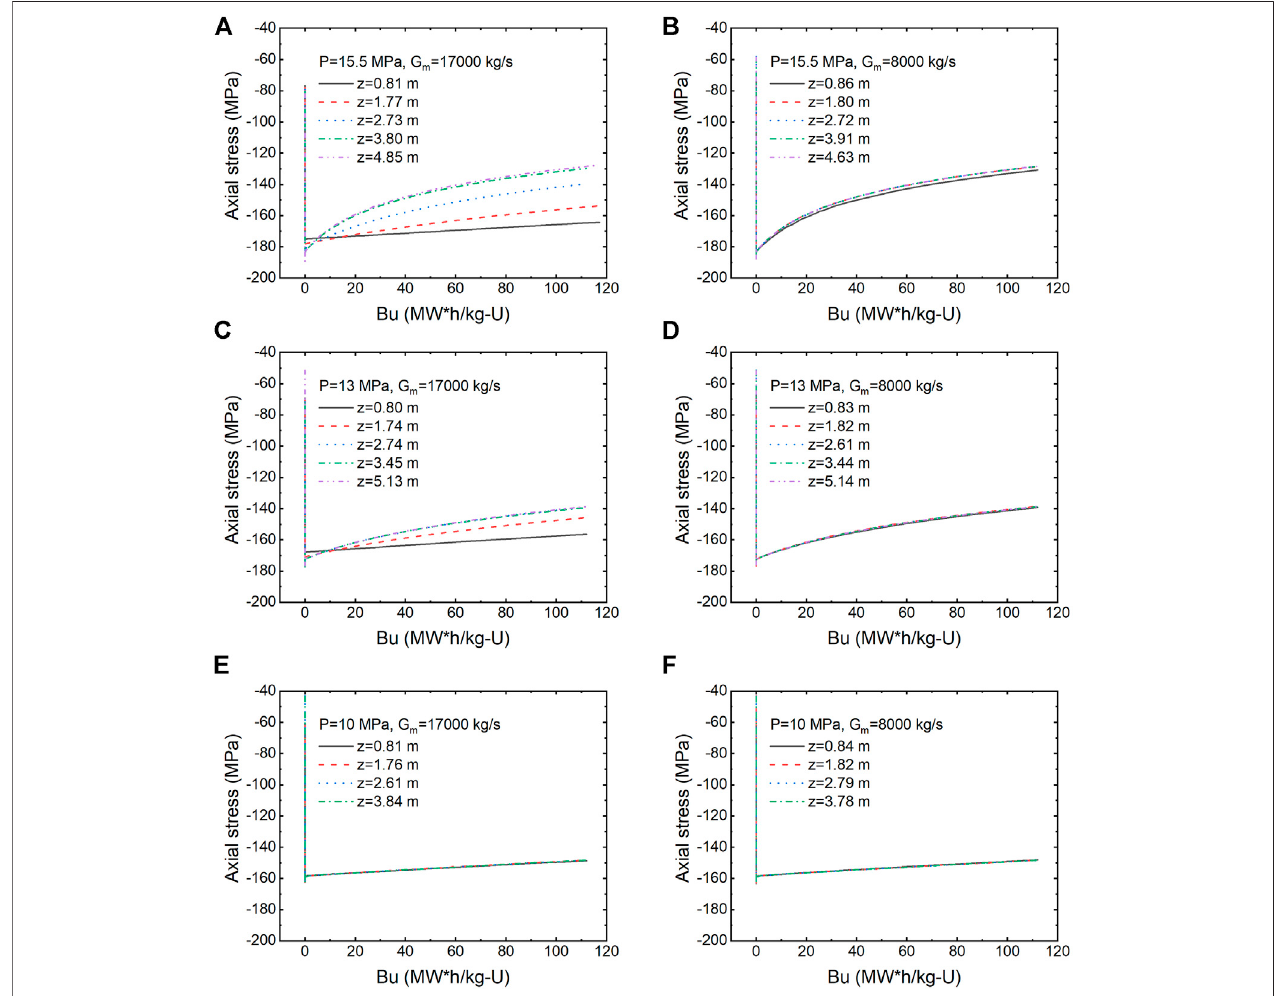
FIGURE 14 | Evolution of axial stress of UO 2 fuel with burnup under different coolant pressures and mass fl uxes.